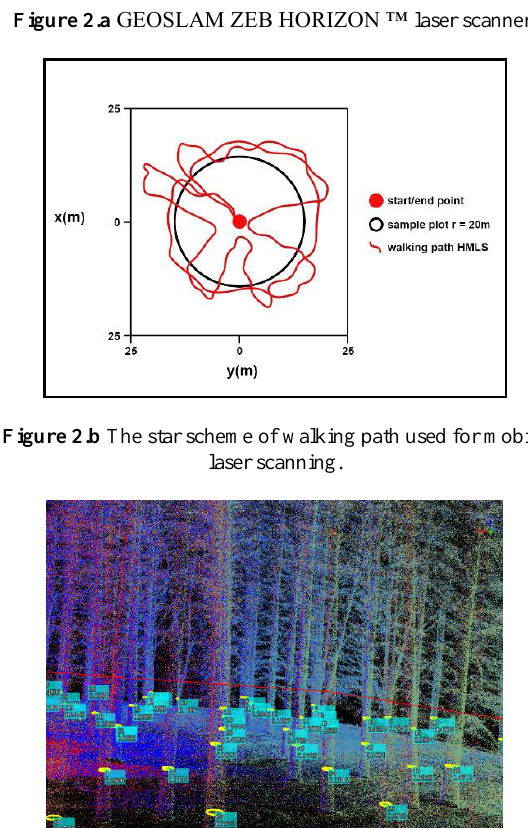
Figure 3 Images of point cloud processing from the graphical user interface of LIDAR360.